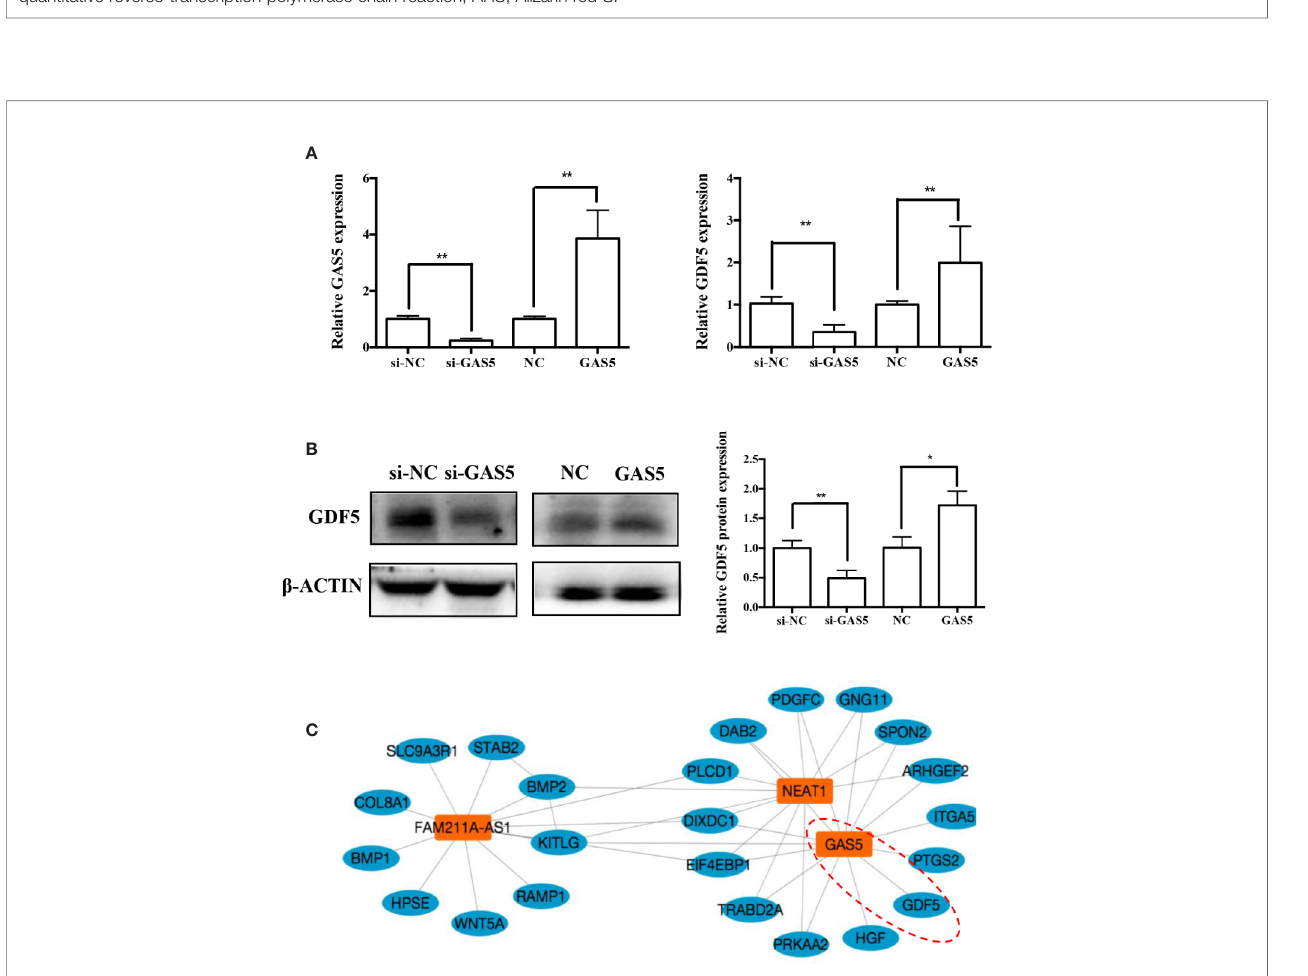
FIGURE 5 | GAS5 regulated the expression of GDF5. (A) : The mRNA expression of GDF5 as is detected by qRT-PCR in si-NC, si-GAS5, NC and GAS5 group. GAPDH was employed for the normalization. (B) : Western blot analysis of the protein expression of GDF5 and the internal control b -ACTIN in si-NC, si-GAS5, NC and GAS5 group. The histogram demonstrates the quanti fi cation of the band intensities. (C) : The co-expression network connections of the module, containing GAS5 and NEAT1. *p < 0.05, **p < 0.01. GAS5, lncRNA growth arrest speci fi c transcript 5; GDF5, growth differentiation factor 5; si-NC, small interfering RNA negative control; si-GAS5, the small interfering RNAs that target GAS5; NC, negative control; GAPDH, glyceraldehyde 3-phosphate dehydrogenase; qRT-PCR, quantitative reverse-transcription polymerase chain